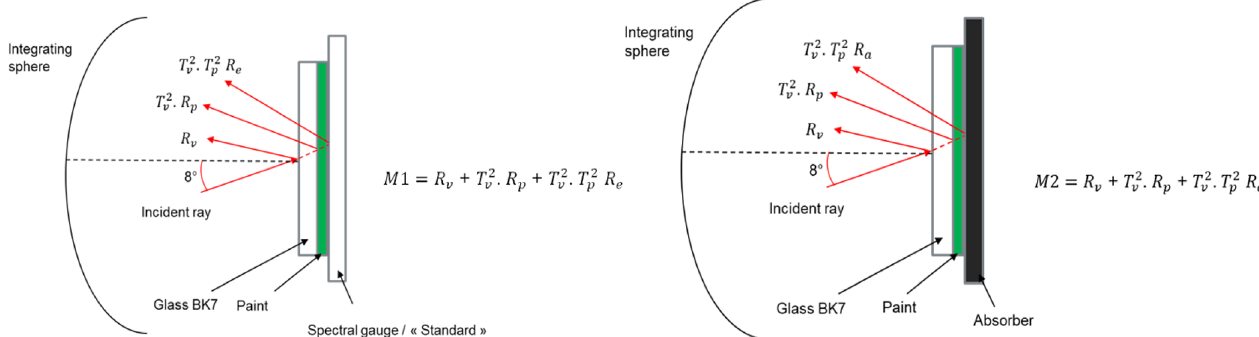
Fig. 2. Overview of the experimental setting for the measurements M1 (left) and M2 (right).